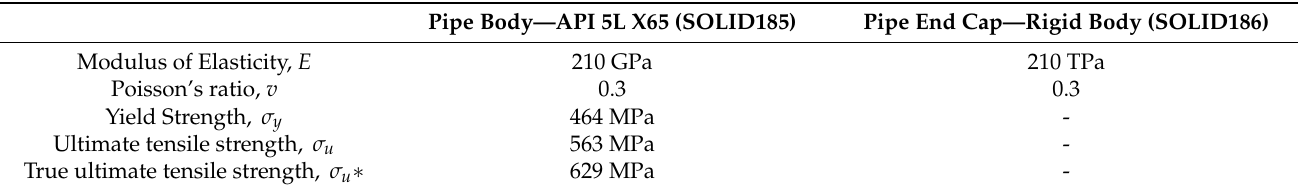
Table 3. Mechanical properties of the pipe